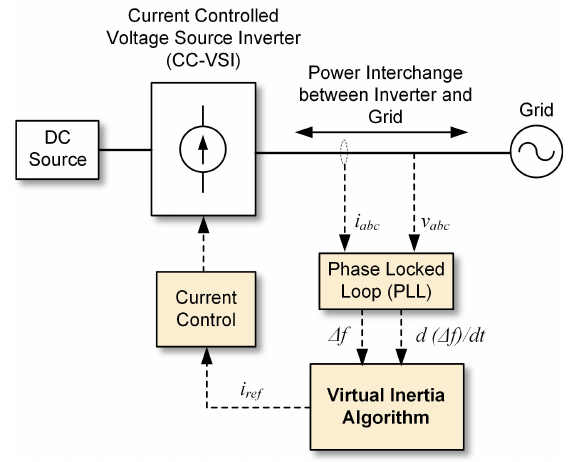
Figure 1. Operating principle of a virtual inertia emulation